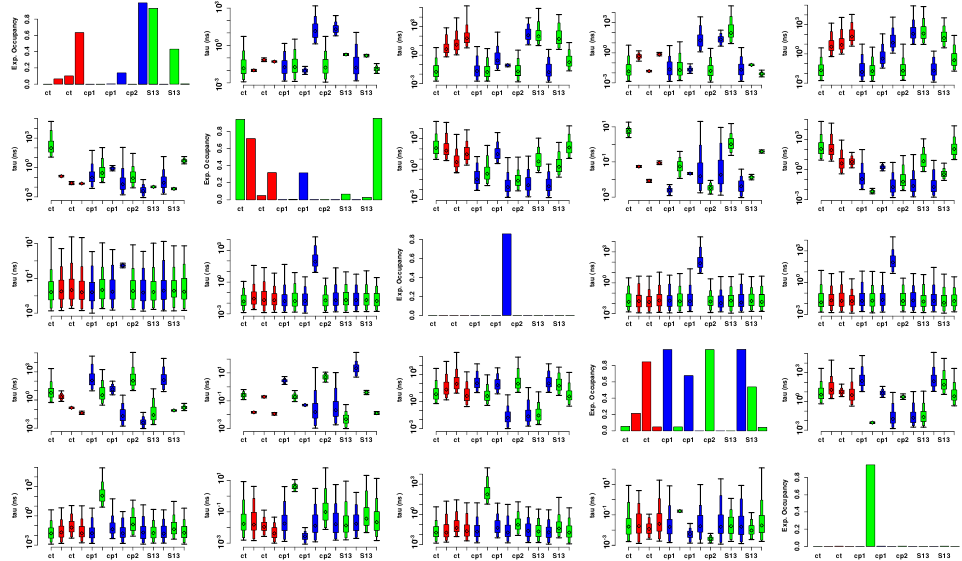
Figure 14. Posterior transition rate and occupancy estimates from the Markov model. States indicated by row/column. Diagonal panels show posterior occupancy probability by protein; colors indicate the thermal group. i , j off-diagonal panels show 95% posterior intervals for estimated waiting times for transitions from state i to state j (in ns), by protein (Note that uncertainty is high for transitions involving states not observed for a given protein, leading to wide posterior